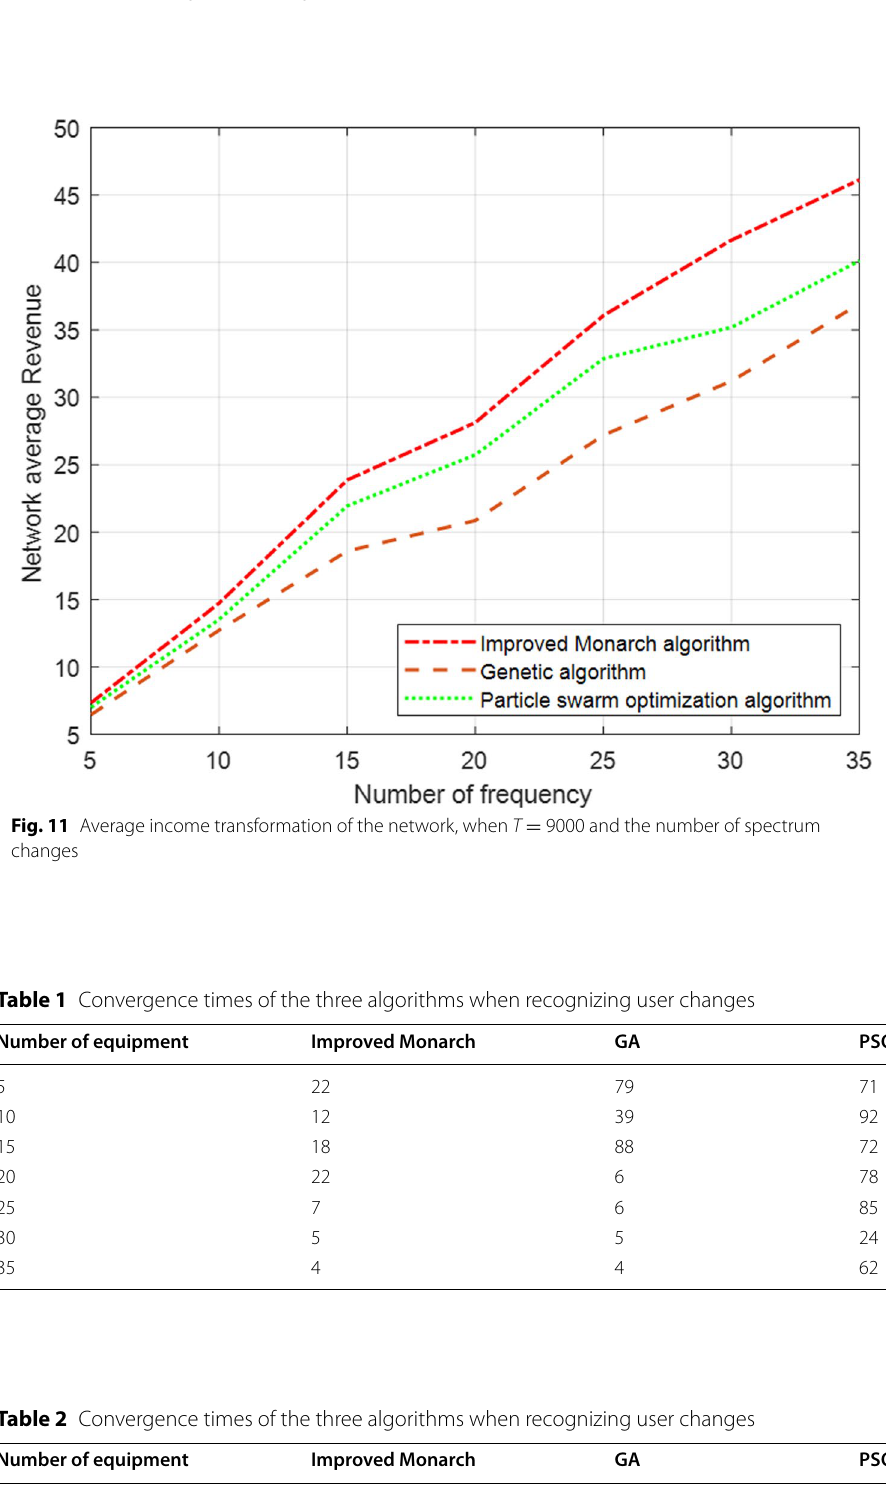
Table 2 Convergence times of the three algorithms when recognizing user changes Number of